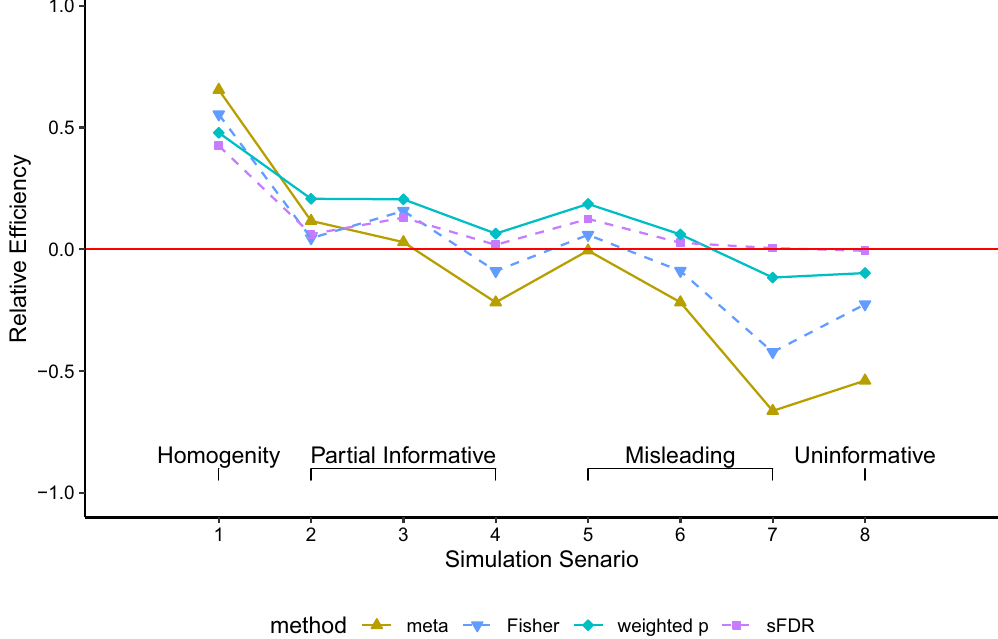
Figure 3. The relative efficiency ( RE ) obtained from simulation study design III, integrating simulated GWAS summary statistics with simulated additional information with varying degrees of informativeness, using meta- analysis, Fisher’s method, the weighted p value approach, and the stratified FDR control. There were 10,000 independent SNPs, among which 100 were truly associated whose summary statistics were drawn from N (3, 1); the rest from N (0, 1). For the additional information available for data integration, the details of the eight simulation scenarios are provided in the text and illustrated in Figure S7. RE is one minus (the average ranks of the truly associated SNP after data-integration) divided (by their average base-line ranks using GWAS data alone), averaged across 1000 simulation